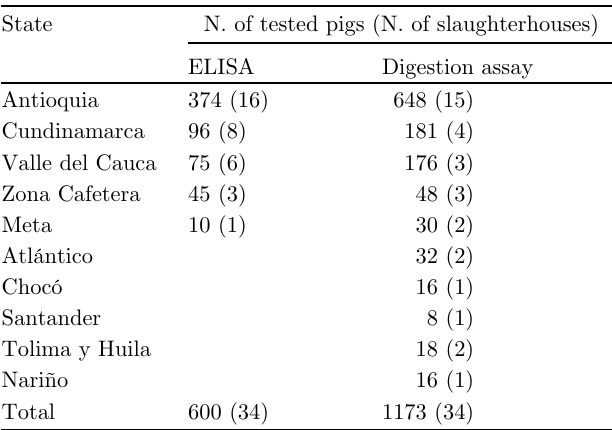
Table 1. Pigs tested for Trichinella infection by the arti fi cial digestion assay or by ELISA per Colombian states in